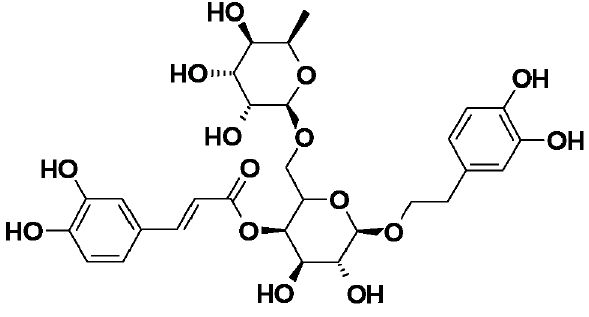
Figure 1. Chemical structure of forsythiaside A.